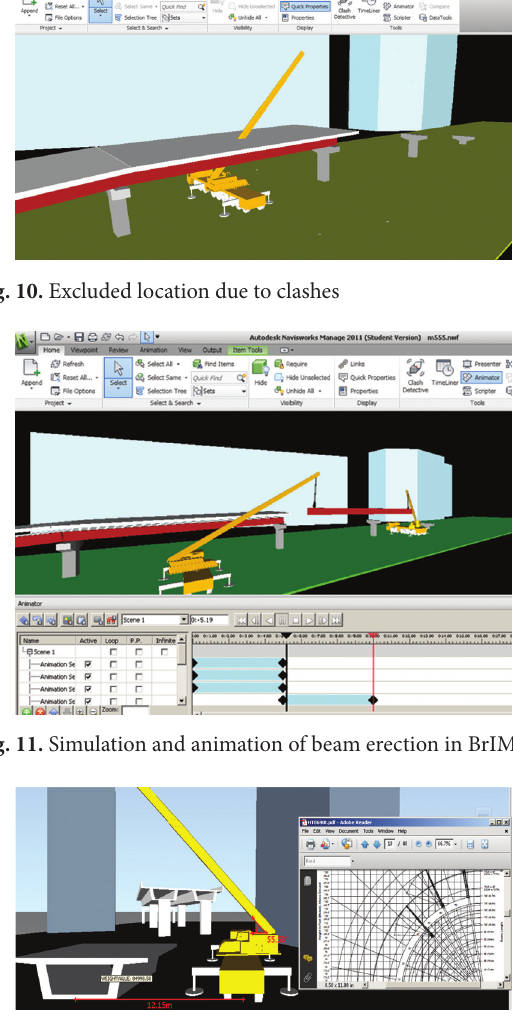
Fig. 12. Checking safety requirement